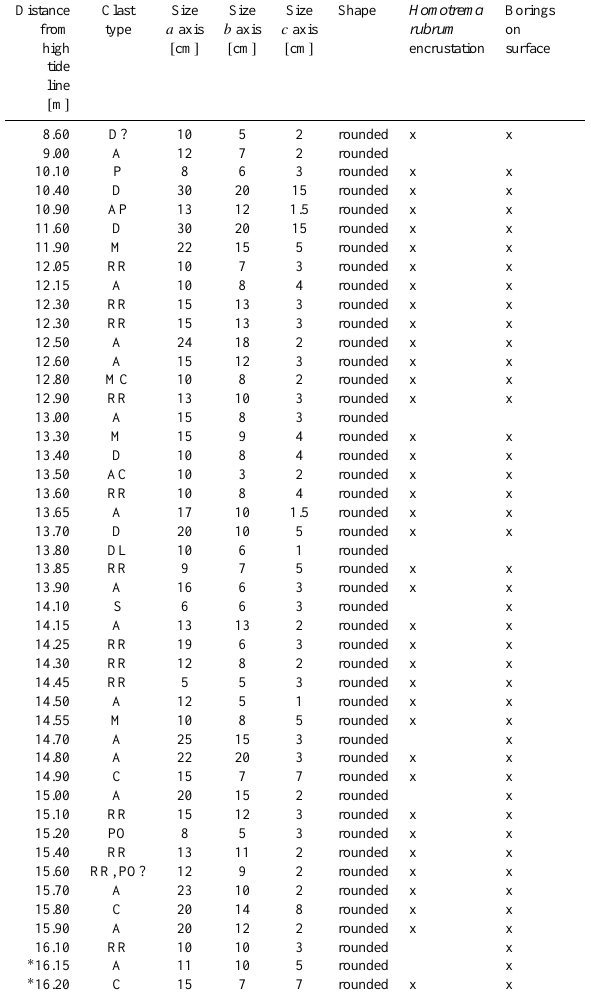
Table A2. Clast parameters of ridge transect II (the star symbol ∗ marks the crest of the